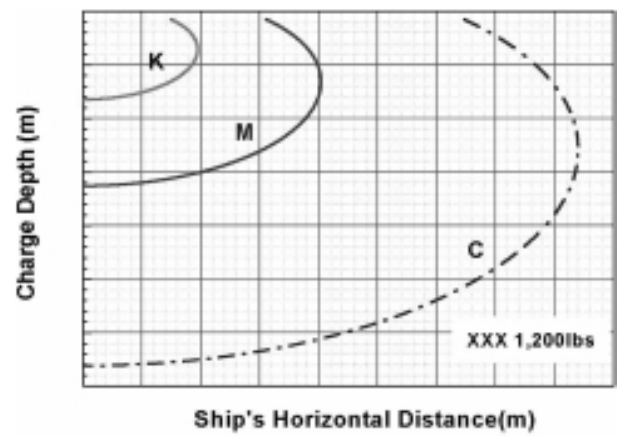
Fig. 15. Simulation results of whole structure’s stress.